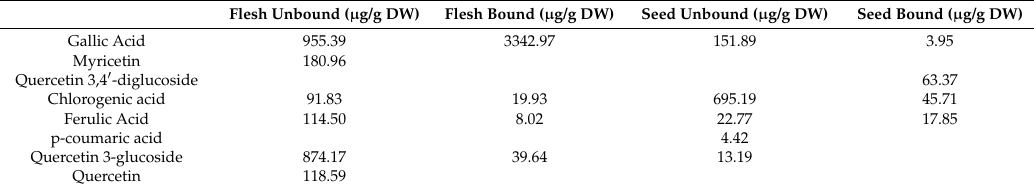
Table 4. Quantified phytochemicals in green plum flesh and seed unbound and bound